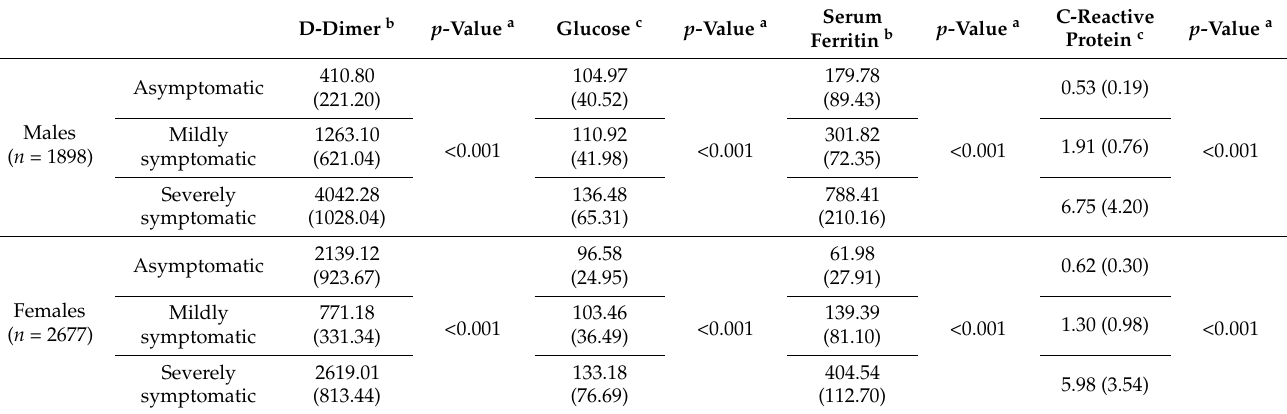
Table 2. Comparison of the analytical parameters’ mean values based on the patient’s symptoms and